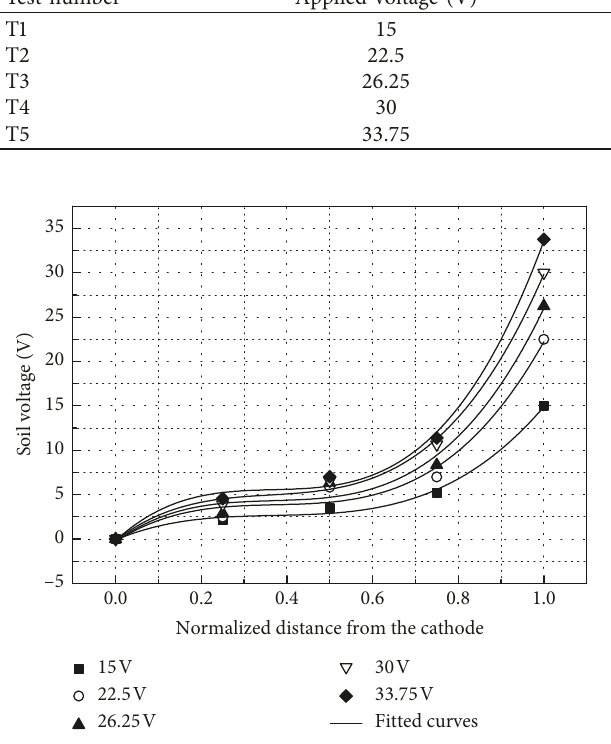
Figure 4: Fitted soil voltage distribution curves at different output voltages.